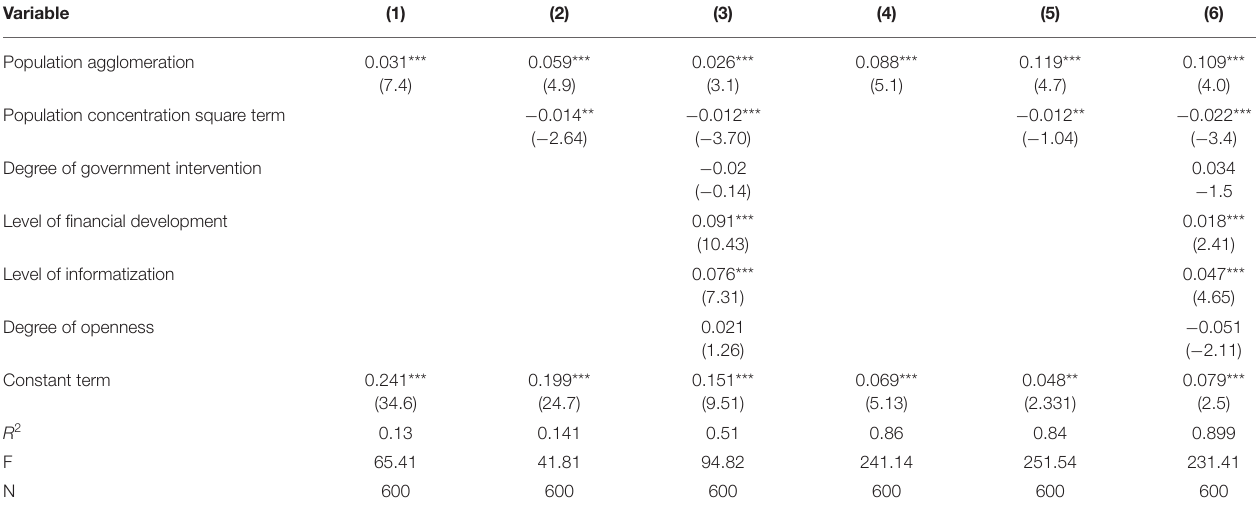
TABLE 2 | Baseline regression results of population agglomeration affecting high-quality development.